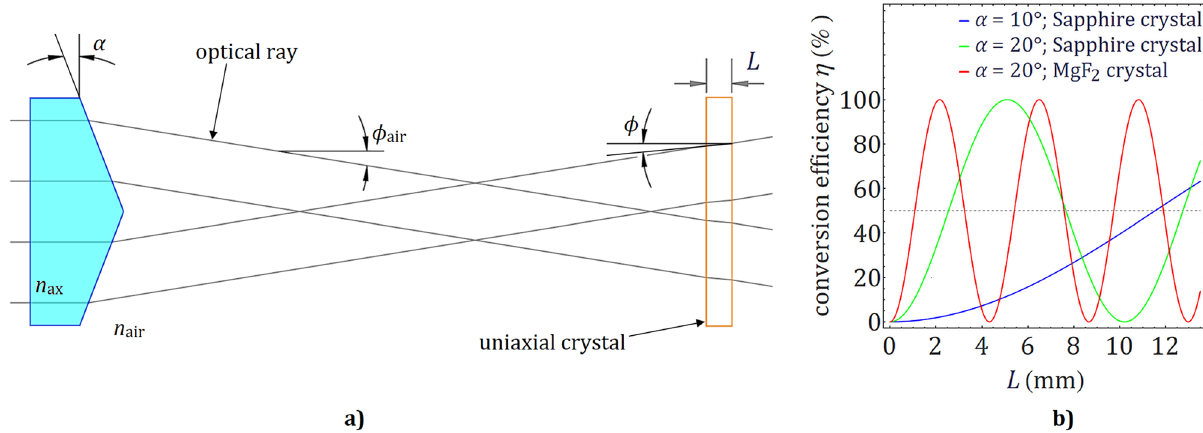
Figure. 1. ( a ) Ray-tracing representation through the first axicon and the uniaxial crystal that shows the connotation of the terms like the length of the crystal L , the physical angle of the axicon α, the tilt angle with of the beam in free space ϕ air , and inside the crystal, ϕ , with respect to the optical axis. ( b ) The conversion efficiency of the fundamental polarization mode as a function of the crystal type and thickness for given values of the physical angle of the axicon, α. The MgF 2 crystal was considered only as an example to show that its characteristics influence the conversion efficiency of the polarization differently from the Sapphire